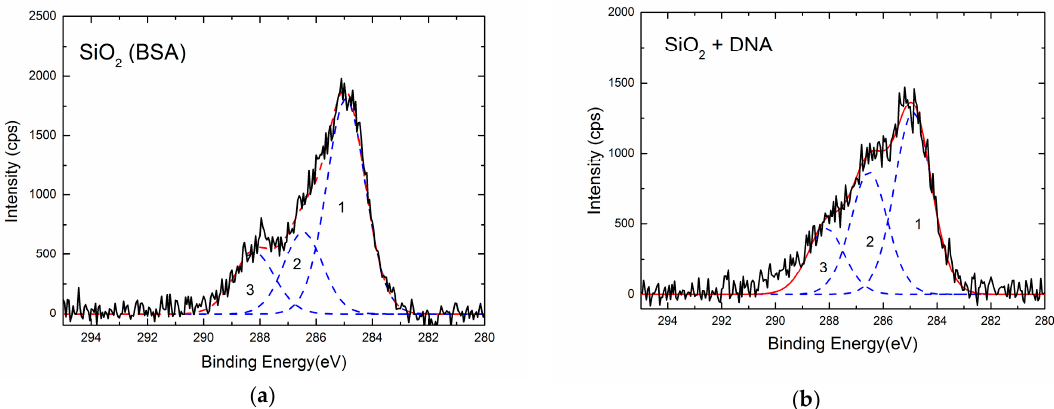
Figure 4. XPS high ‐ resolution C1s spectra of SiO 2 surface before ( a ) and after ( b ) ssDNA Figure 4. XPS high-resolution C1s spectra of SiO 2 surface before ( a ) and after ( b ) ssDNA immobilization immobilization ( black line ). Details of C1s peak components ( blue dashed lines ) and their ( black line ). Details of C1s peak components ( blue dashed lines ) and their convolution ( red dashed convolution ( red dashed line ) are also shown. line ) are also shown.